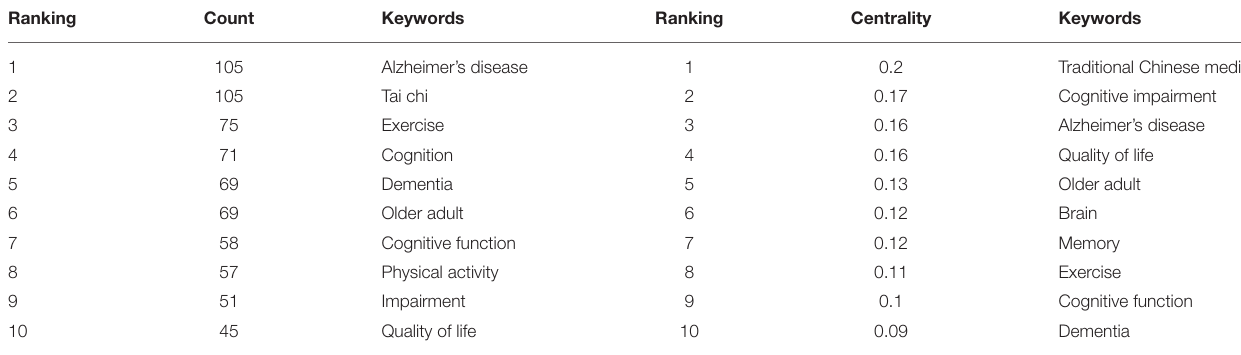
TABLE 5 | Top 10 keywords in terms of frequency and centrality from 2001 to